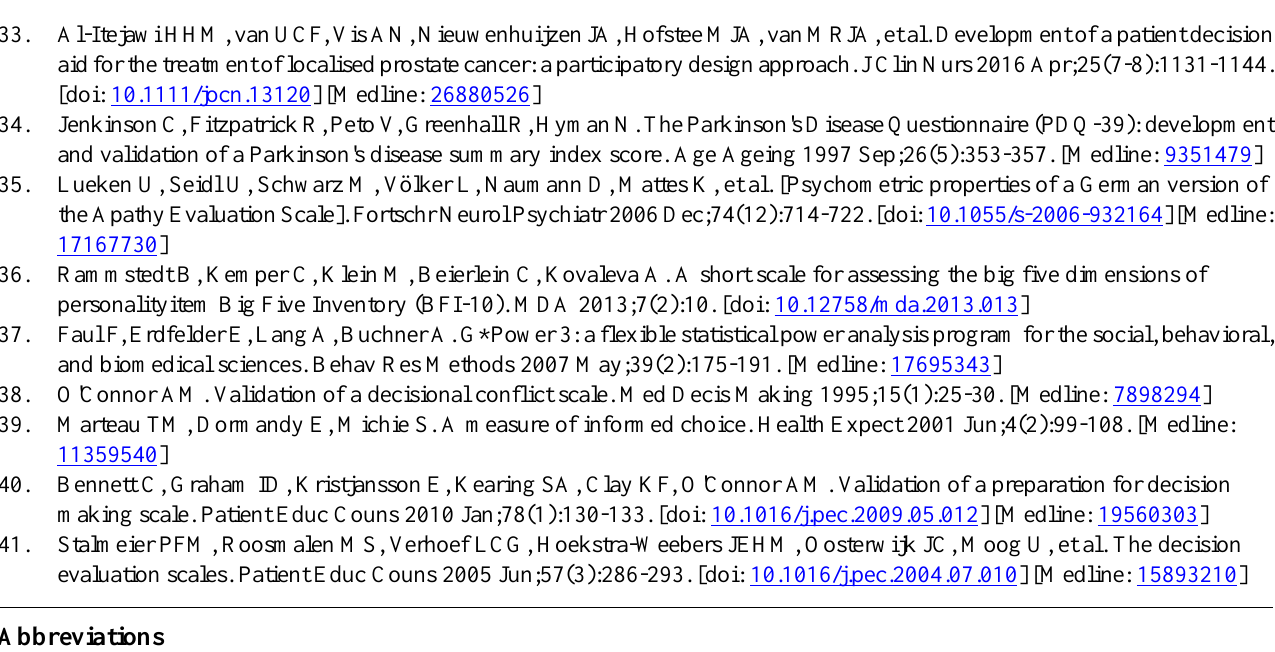
PDQ: Parkinson Disease